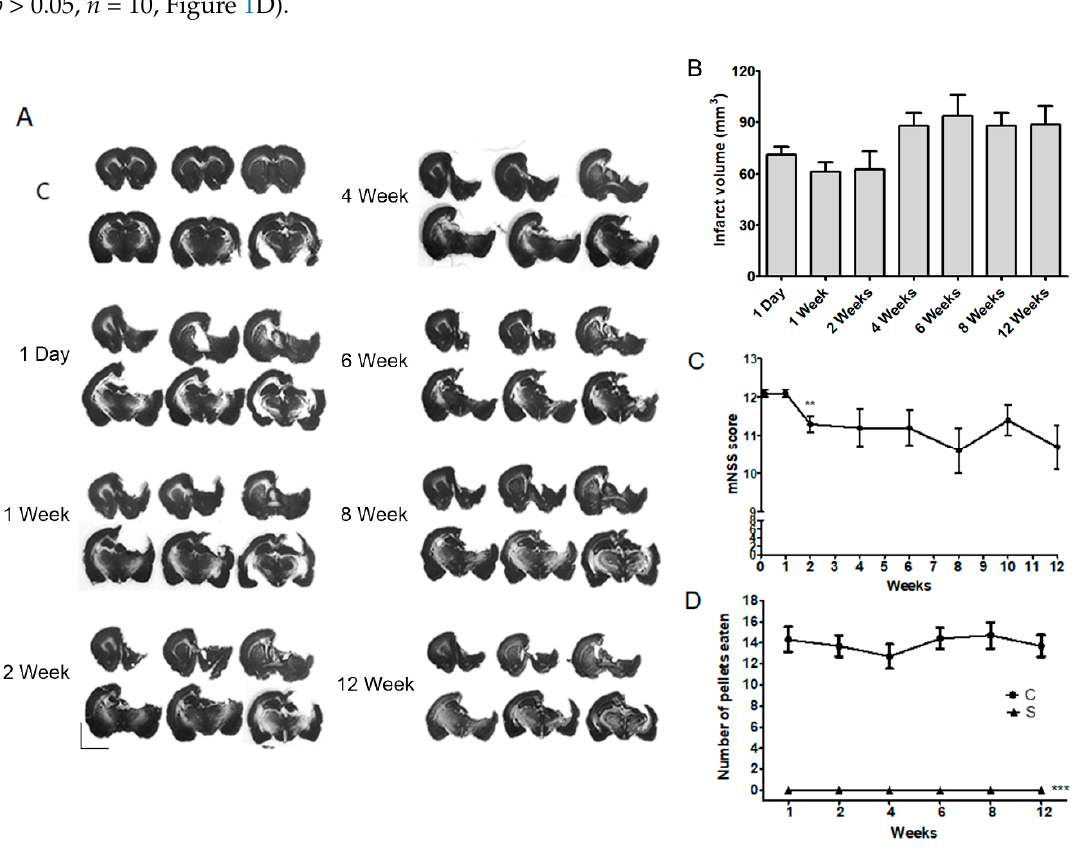
Figure 1. Evaluations of infarct volume and motor function from acute to chronic stages after a photothrombic ischemic stroke: ( A ) Representative photomicrography of Nissl-stained sections at several time points after a stroke; ( B ) Quantification of infarction size did not differ among time points after a photothrombic ischemic stroke (S). Results are presented as the mean ± SEM, n = 6; ( C ) while